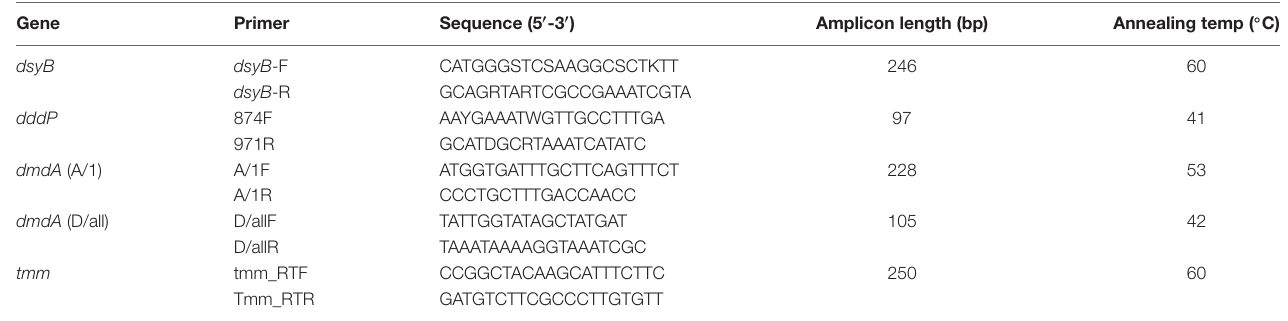
TABLE 1 | Primers and amplification conditions for quantitative PCR of bacterial DMSP cycling